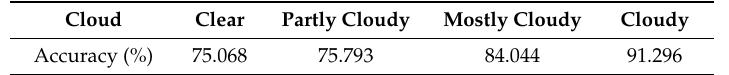
Table 5. The result of the discriminant for movement of clouds by wind direction.